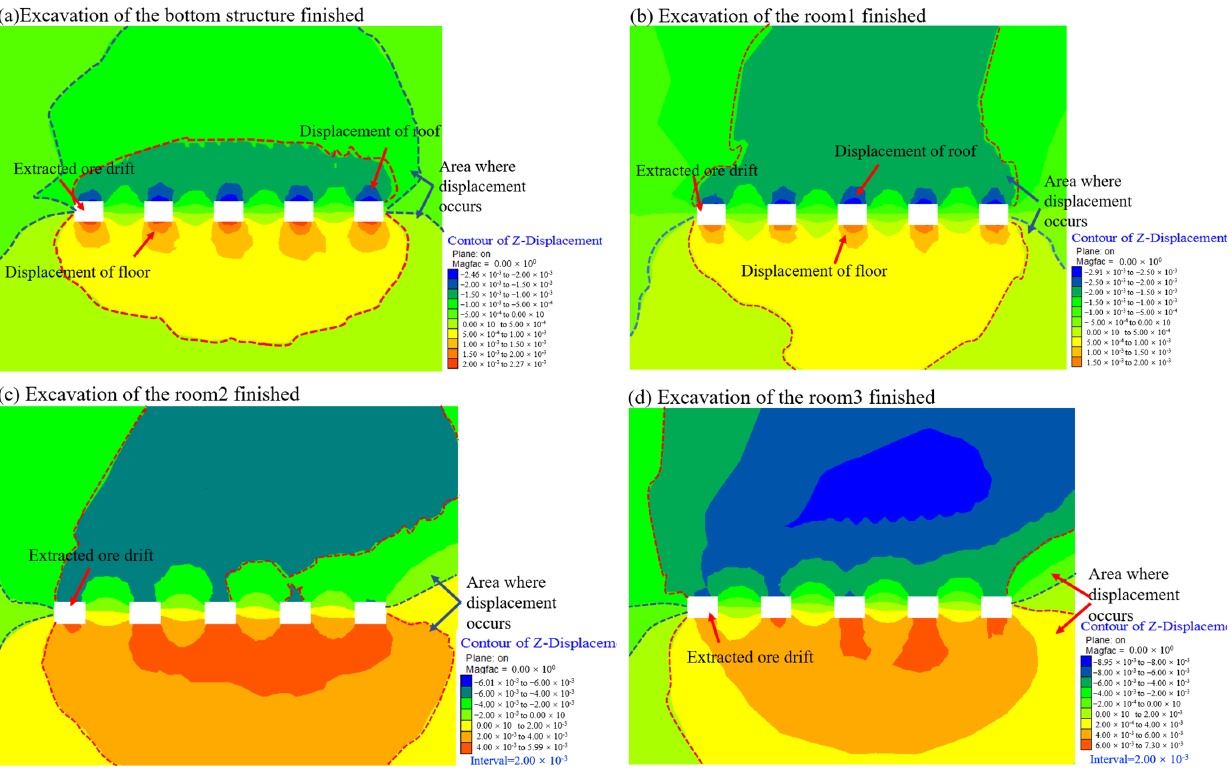
Figure 5. Displacement of the excavation. ( a ) Excavation of the bottom structure finished ( b ) Excavation of the room 1 finished ( c ) Excavation of the room 2 finished ( d ) Excavation of the room 3